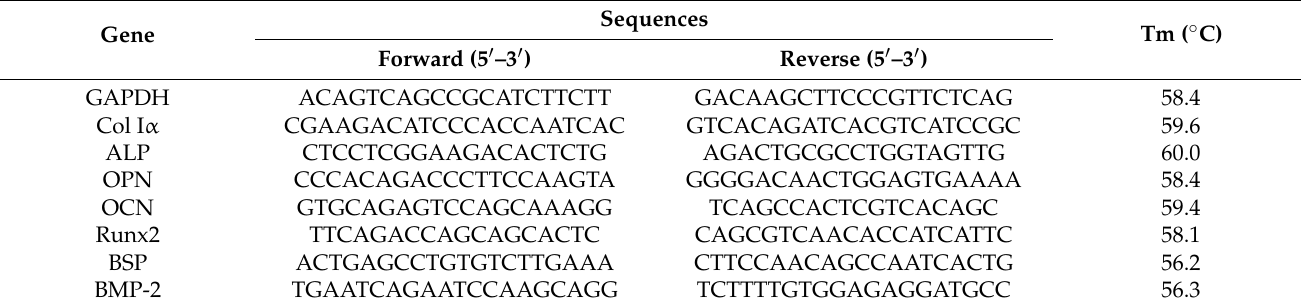
Table 1. List of primers for the osteogenic genes of